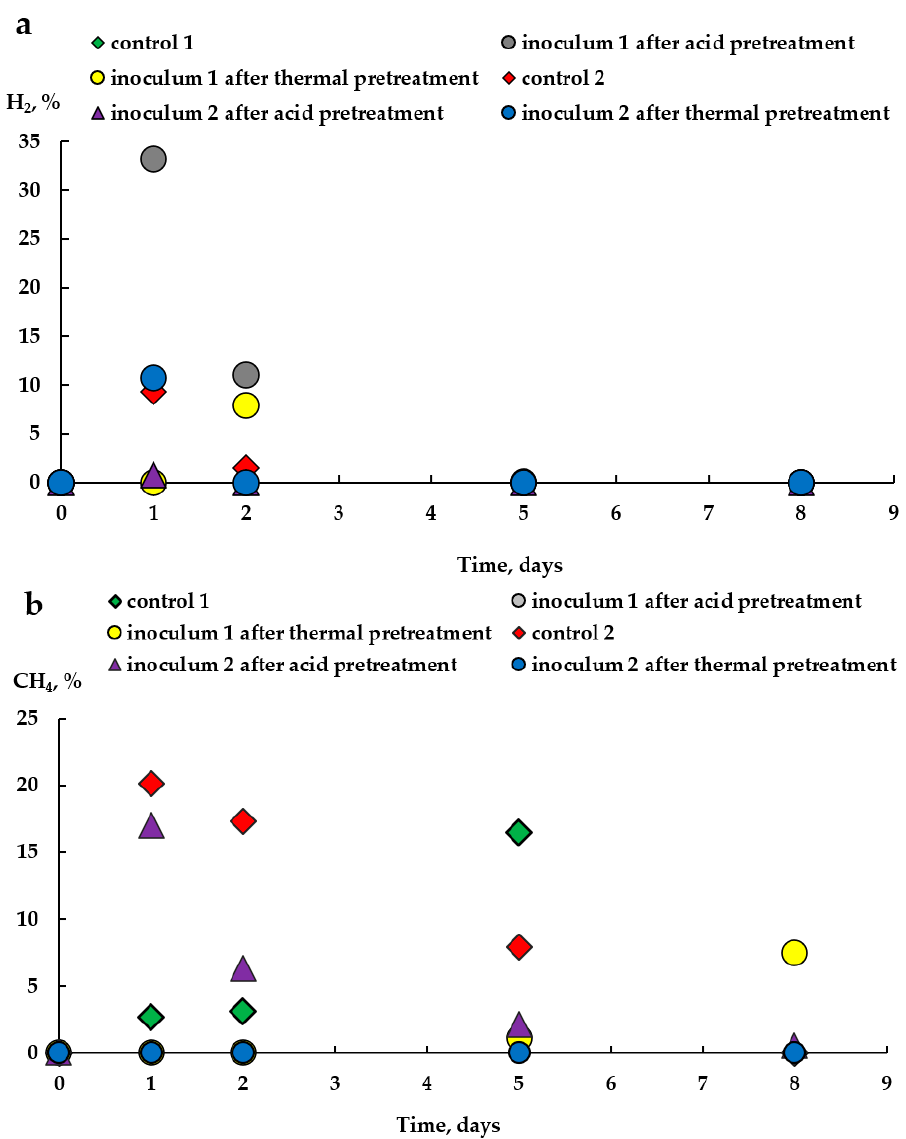
Figure 2. Content of hydrogen ( a ) and methane ( b ) in biogas. Acetic and butyric acids predominated among the metabolites formed (Figure 3). Par- ticularly strong acidification on the 8th day of the experiment was observed for inoculum 1 and inoculum 2 after acid pretreatment (up to pH = 3.94 and pH = 4.04, respectively), and for inoculum 2 after heat treatment (up to pH =